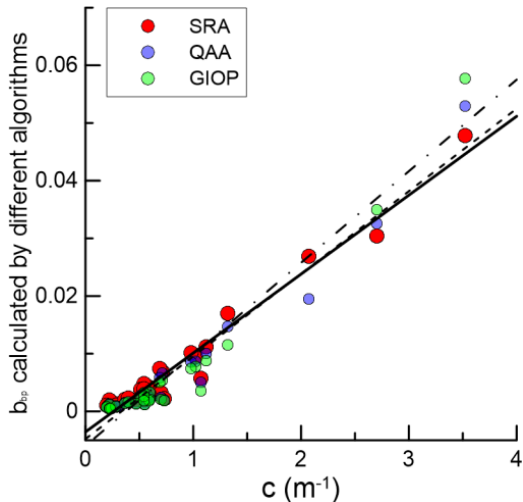
Figure 12. Comparison of the particle backscattering coe ffi cient b bp (555) with the beam attenuation coe ffi cient c (530) for the Barents Sea. Red circles—SRA algorithm, blue—QAA algorithm, green—GIOP algorithm. The black line is a correlation based on SRA, black dotted line—correlation based on QAA data, dash-dotted line – based on GIOP data.